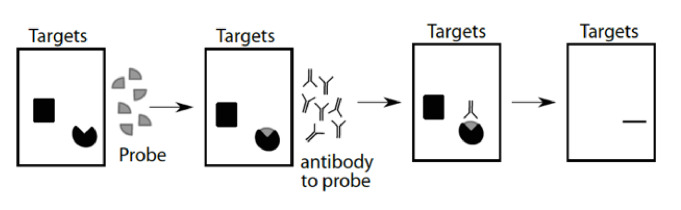
Far western blot schematic.Purified proteins are separated by SDS-PAGE (target proteins) and then transferred to a membrane. Proteins on the membrane are renatured and then probed with purified proteins (probe), cross-linked, and subsequently detected with antibodies.